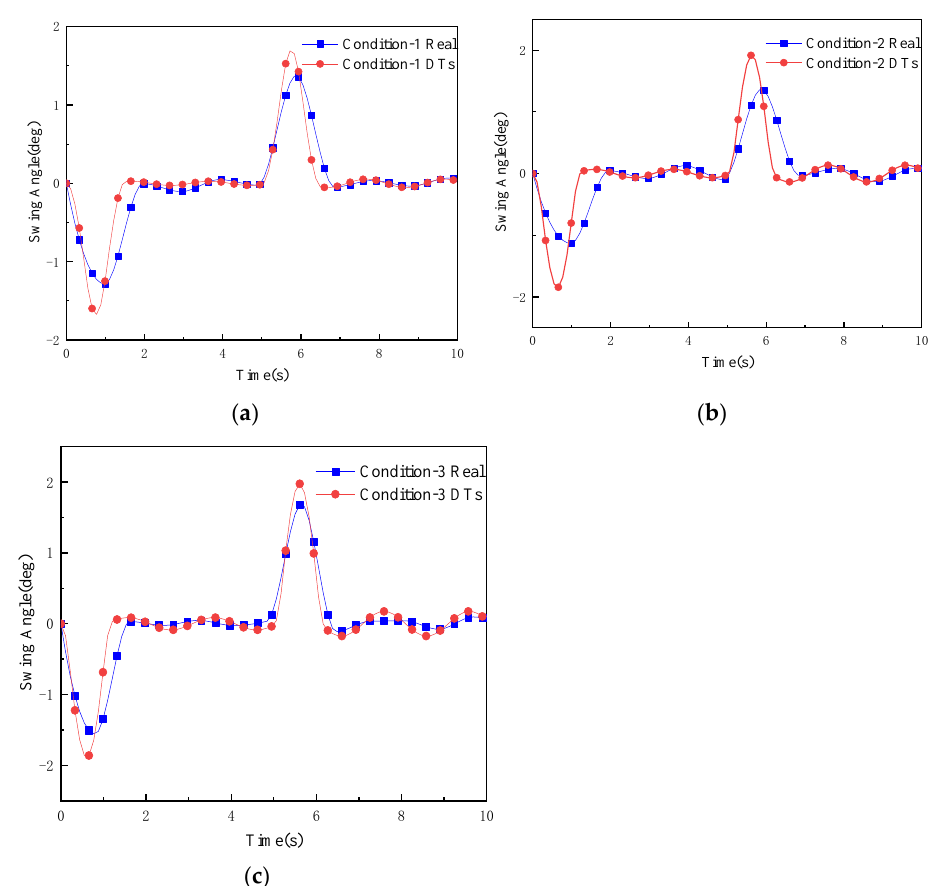
Figure 14. Comparison of load swing angles in Condition Real and Condition DTs under three working conditions: ( a ) condition 1; ( b ) condition 2; ( c ) condition 3.